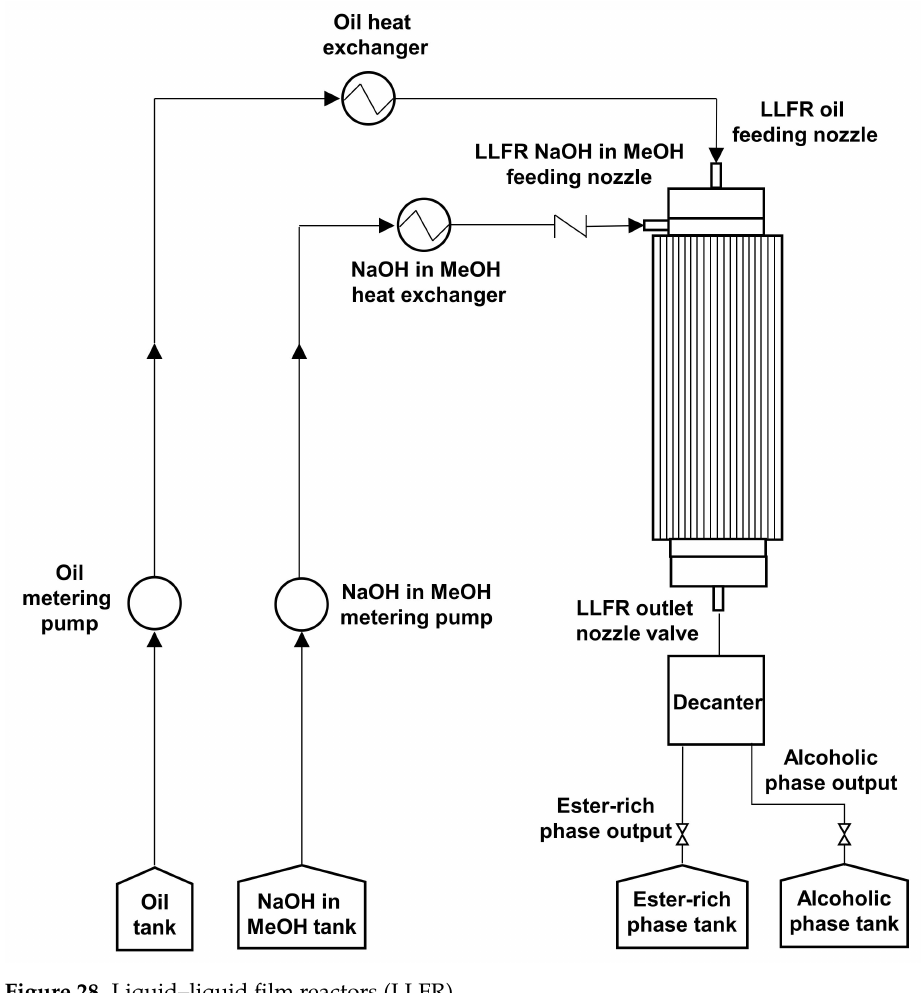
Figure 28. Liquid–liquid film reactors (LLFR).